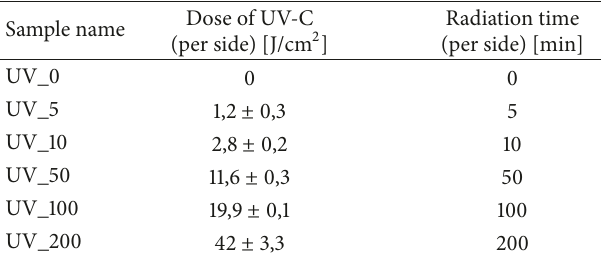
Table 1: List of the processed samples with indicated dose of UV-C (per side) and exposure time (per